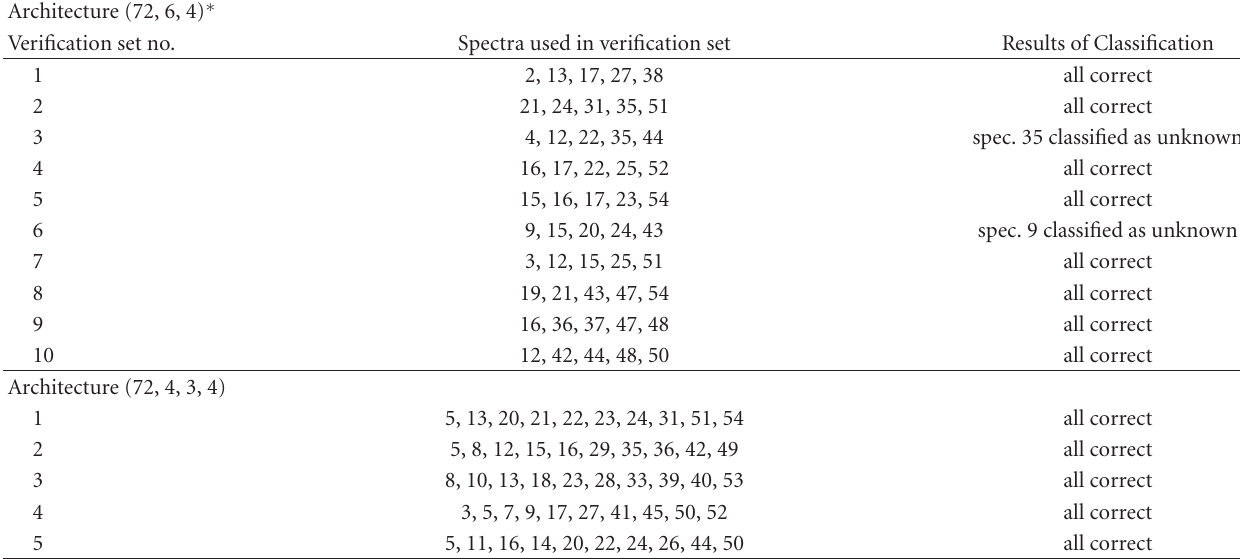
Table 1: Results of cross-validation verification process for the three- and four-layer ANN